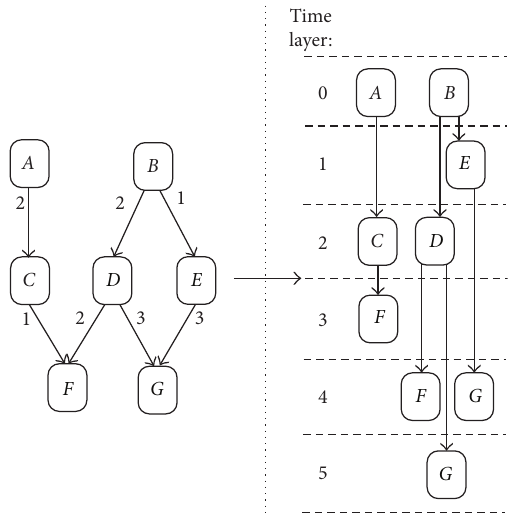
Figure 3: Generating a forest (on the right-hand side) based on a tech tree (on the left-hand side) and representing the optimal times to achieve technologies via different routes topologically. The numbers next to the tech tree edges are corresponding time requirements.